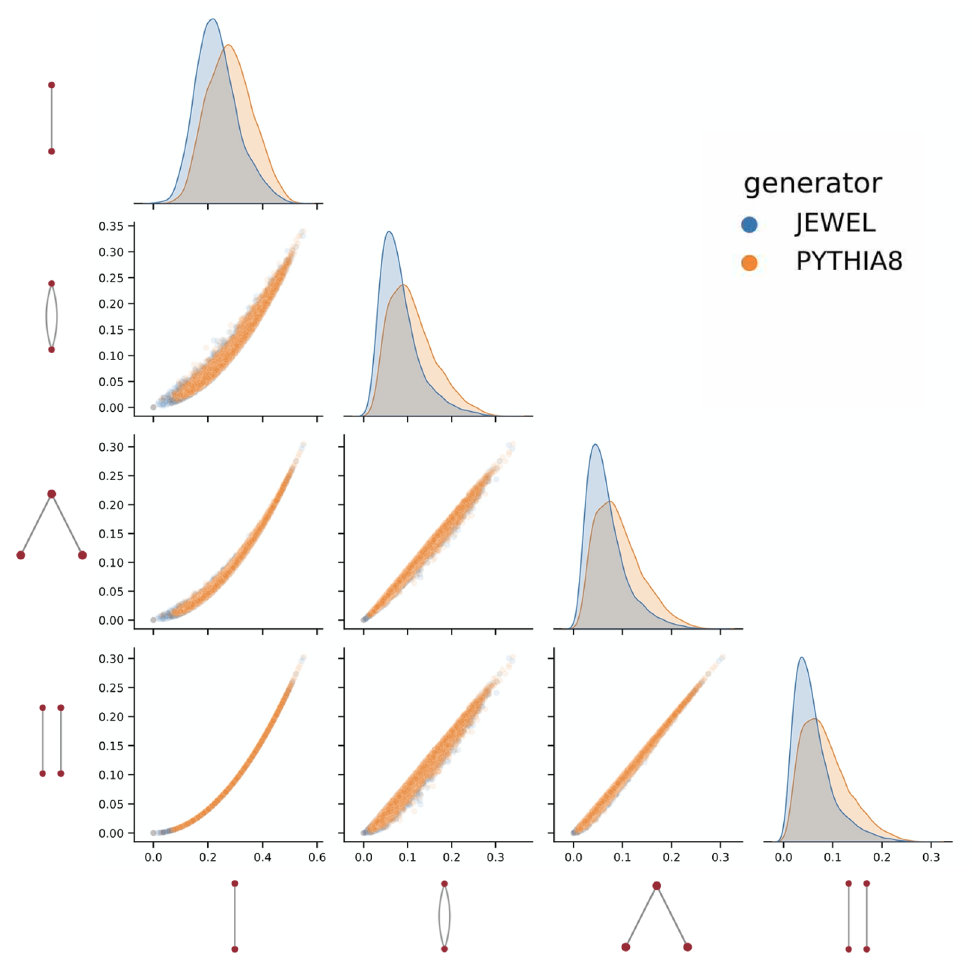
Figure 5 . Scatter plot showing different EFP distributions (diagonal) and their pairwise corre- lations (off-diagonal panels) in pp and AA collisions without background. The pp and AA results shown here are obtained from Pythia 8 [70] and Jewel [72, 73],